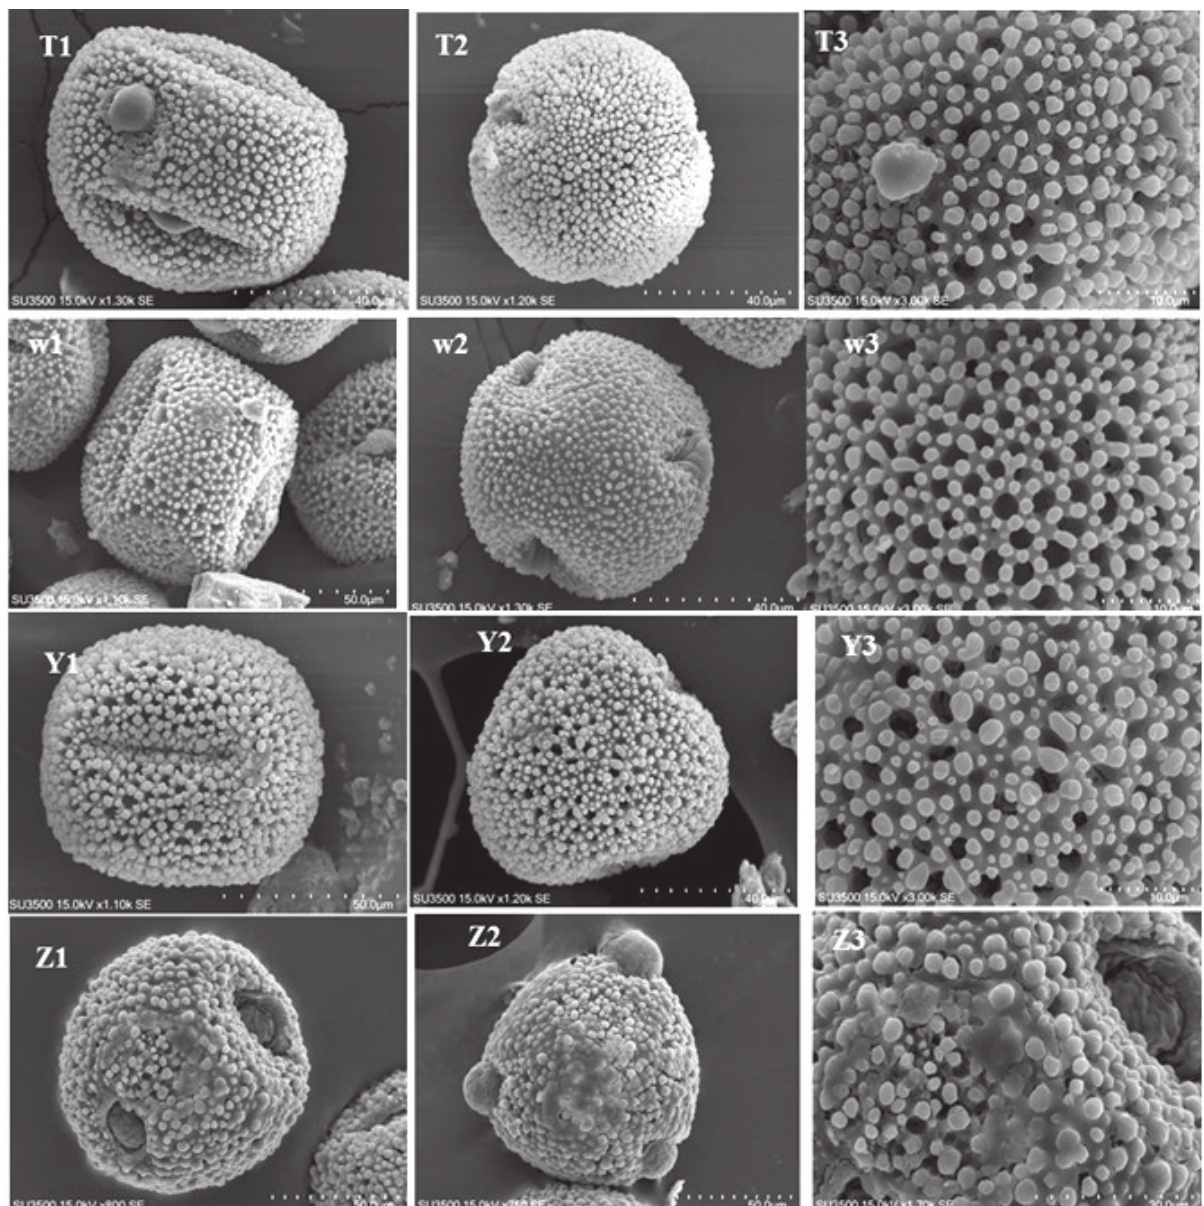
Figure 6. Pollen micrographs of Geranium species: T1-T3: G. kotschyi , W1-W3: G. linearilobum, Y1-Y3: G. tuberosum , Z1-Z3: G. platypeta- lum ; T1,W1,Y1, Z1 – equatorial view; T2,W2,Y2, Z2 - polar view; T3,W3,Y3, Z3 -exine